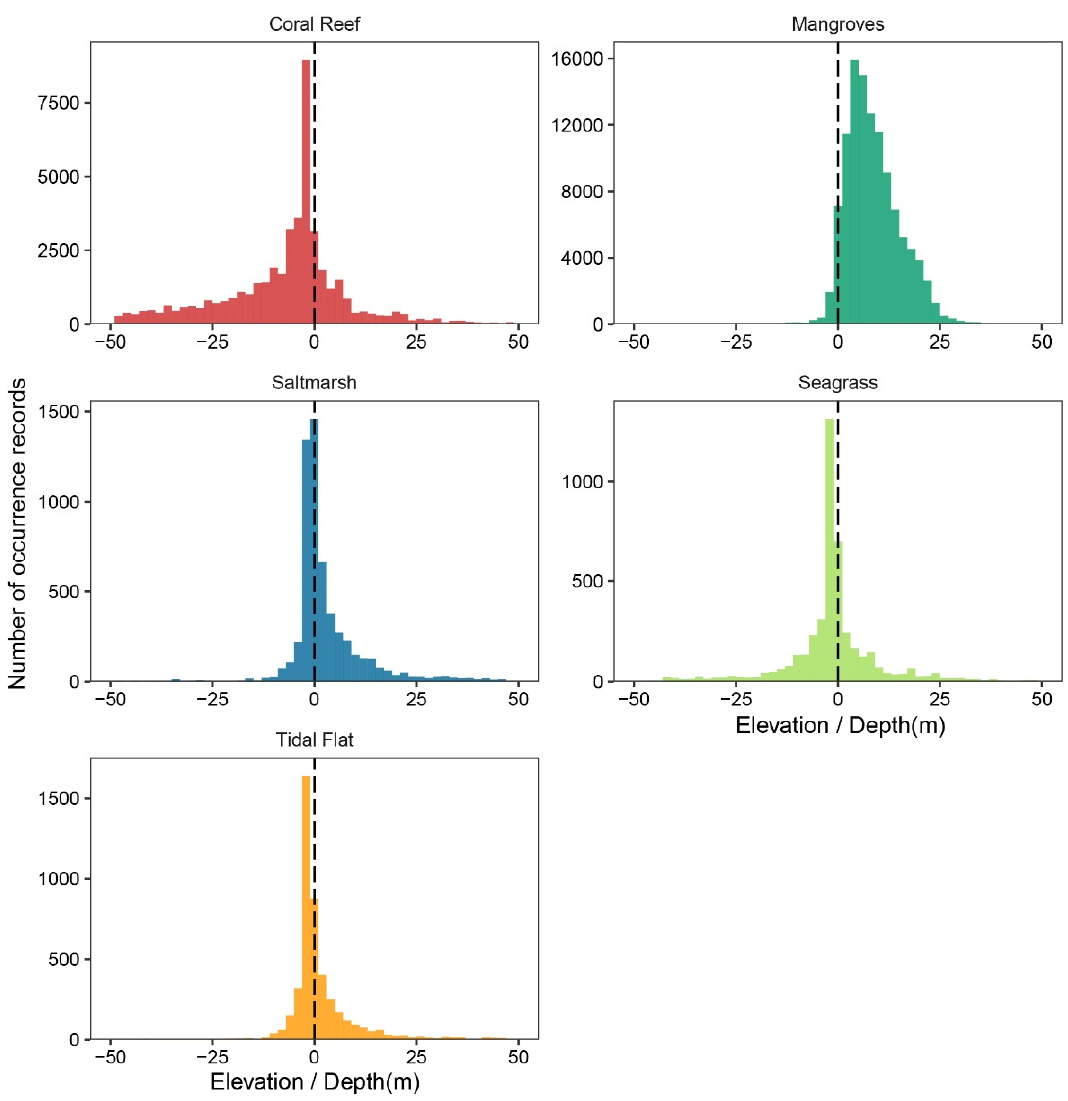
Figure 3. Elevation and depth summaries of each class in the coastTrain dataset. Each coastTrain data record was intersected with the ETOPO global relief dataset [41] to obtain their mapped elevation and depth with reference to sea level (0 m). Histograms for poorly represented coastal ecosystems (rocky shores and kelp forests) or for the ‘permanent water’ and ‘terrestrial other’ classes are not presented in this figure. Note that ETOPO integrates regional and global datasets into a global relief model developed at 1 arc-minute resolution.